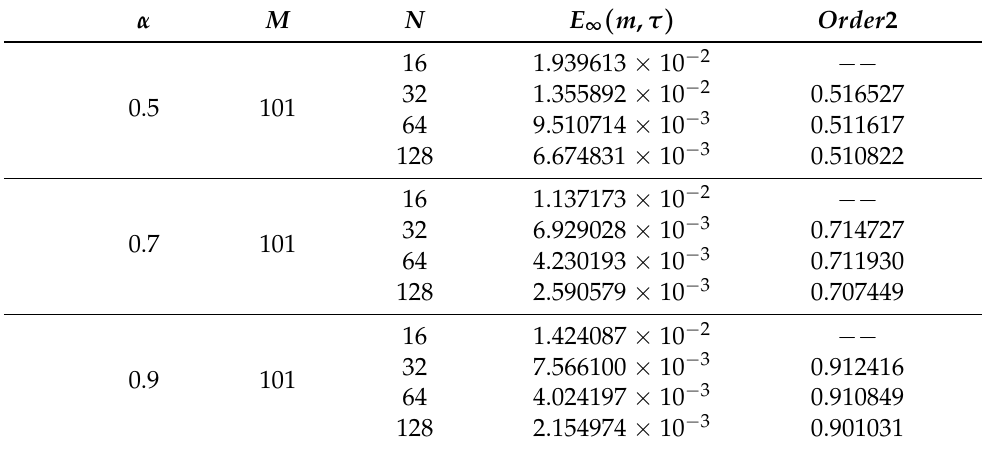
Table 6. Numerical error and temporal convergence of HASC-N difference scheme for Example